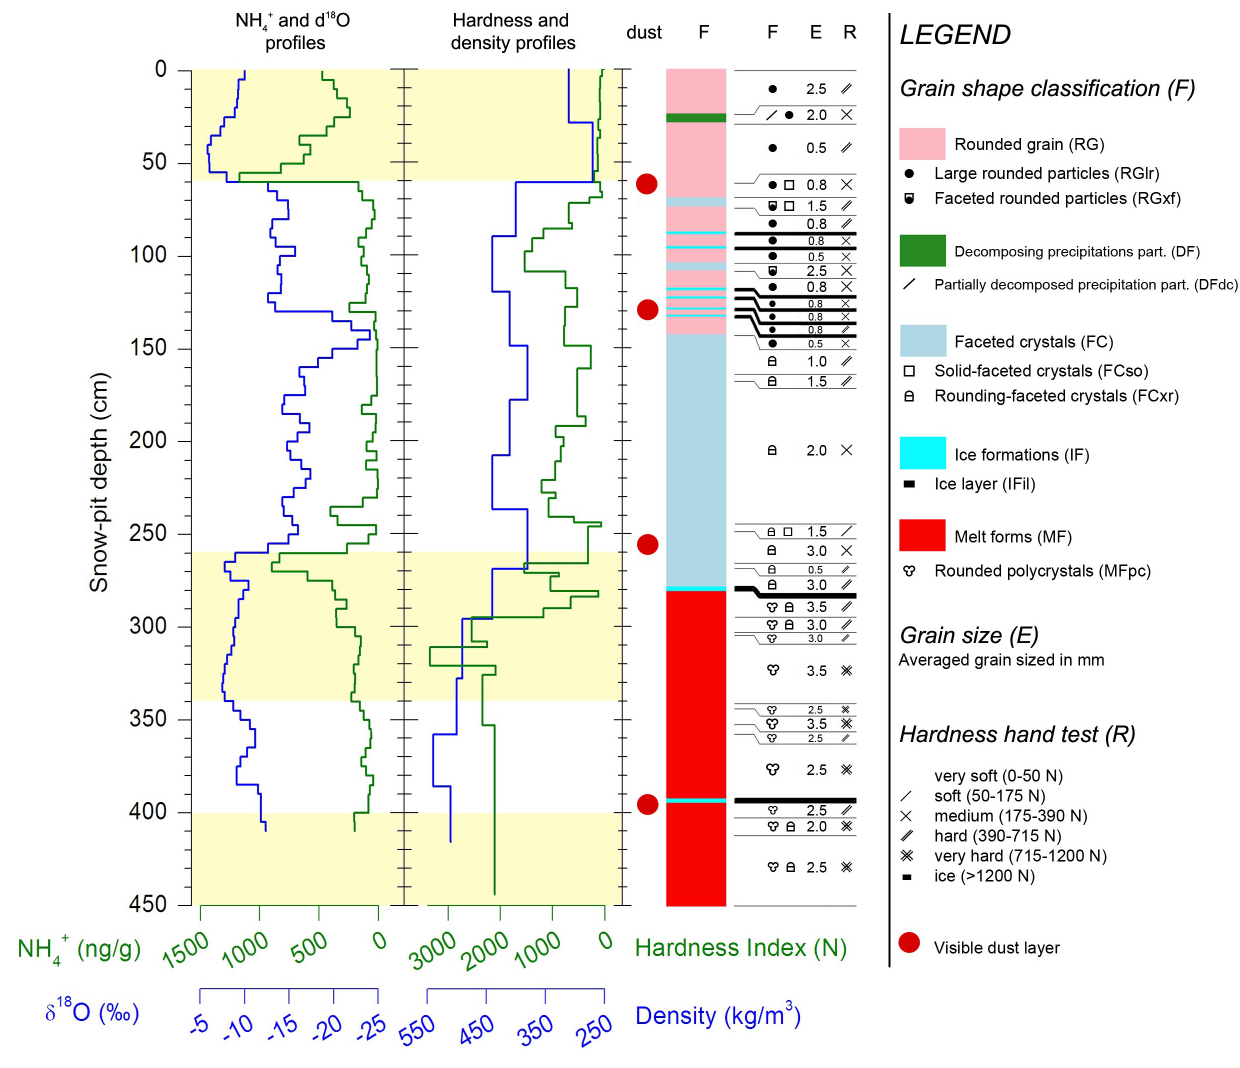
Fig. 2. Stratigraphic observations (grain shape and size), density, hardness index, δ 18 O and NH + the Alto dell’Ortles glacier. The grain shape has been classified in accordance with the International Classification for Seasonal Snow on the Ground (Fierz et al., 2009); in brackets the synthetic crystal shape code is